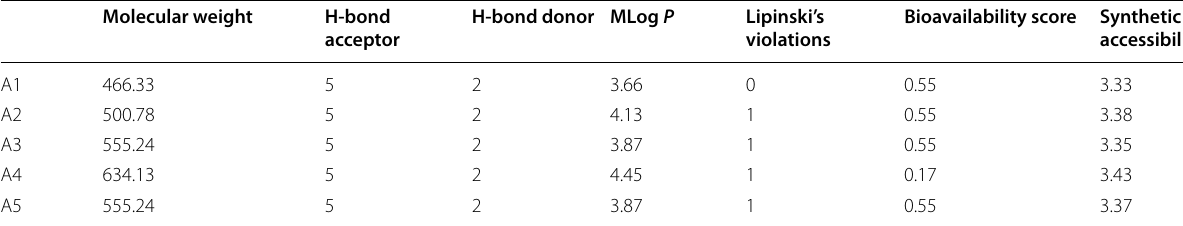
Table 8 Drug-likeness properties of the designed analogues Molecular